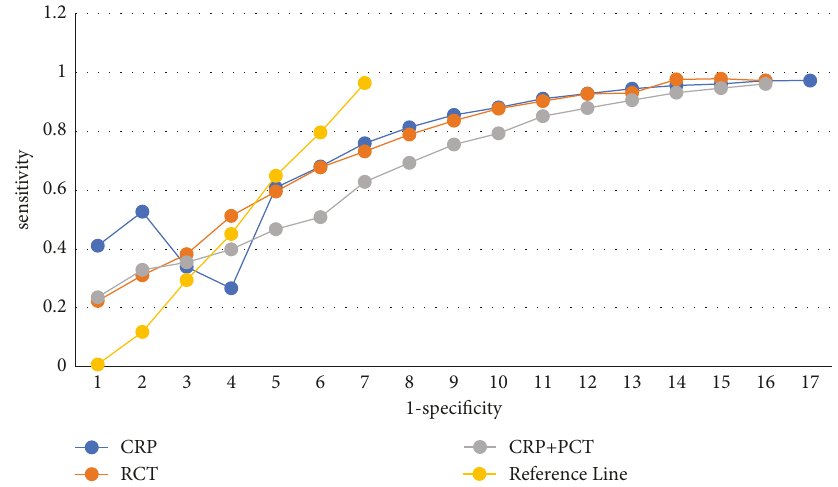
Figure 3: ROC curves of CRP, PCT, and CRP +PCT in diagnosis of sepsis. Note: CRP: C-reactive protein; Pct: procalcitonin. Statistical method: ROC curve analysis.